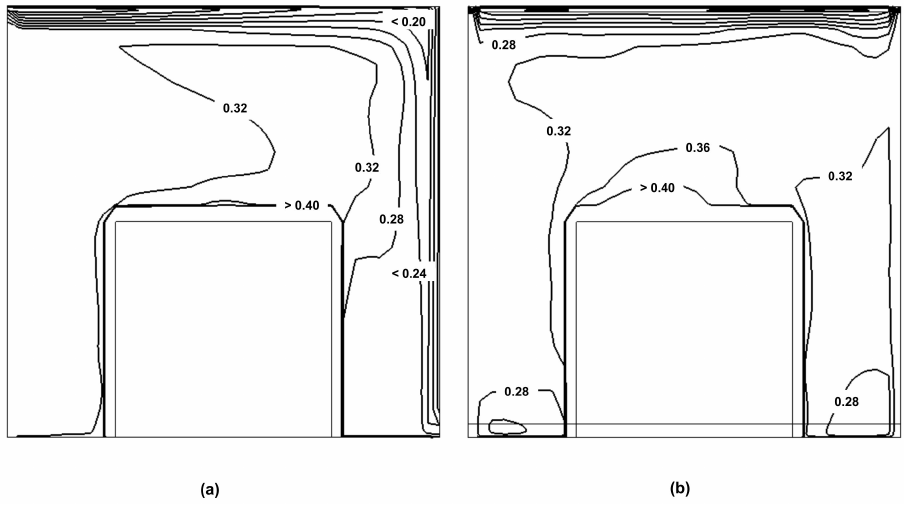
Figure 4. Contours of normalized temperature on mid-plane in ( a ) streamwise direction and ( b ) span- wise direction for case